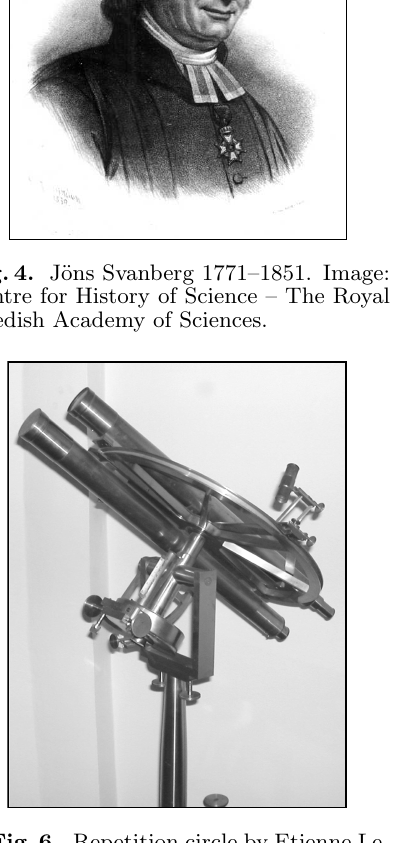
Fig. 7. Oscar Backlund 1846{1916. Im- age: Virtual Museum of the Tartu obser-